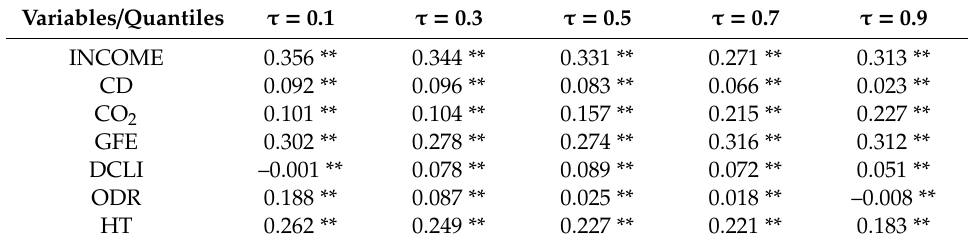
Table 5. Coe ffi cient estimates of BQR in di ff erent quantiles ( τ = quantile). Variables /